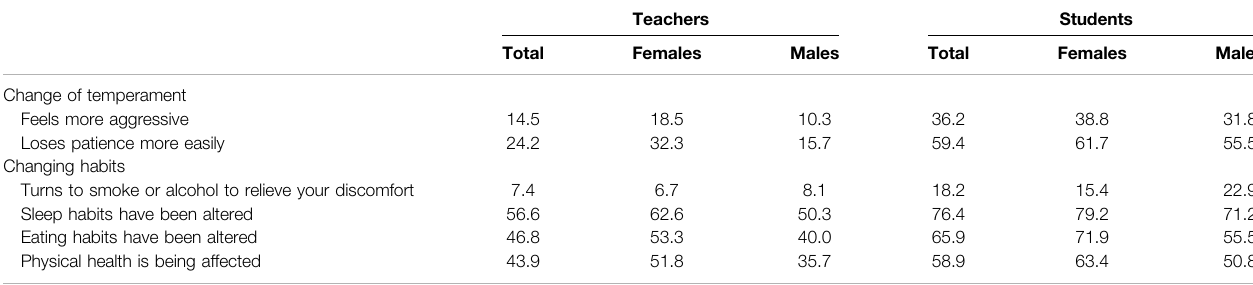
TABLE 5 | Changes in temperament and habits in teachers and students resulting from the change in teaching modality.